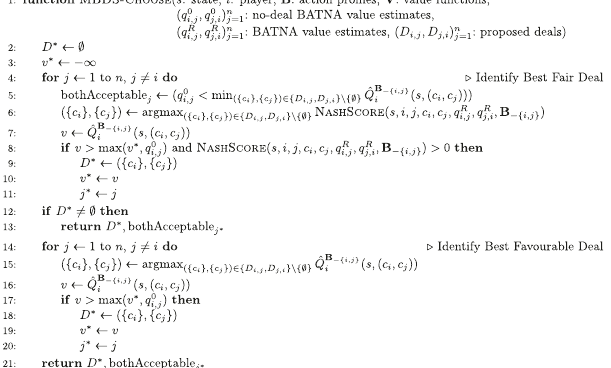
Algorithm 6 Mutually Bene fi cial Deal Sampling Choice.